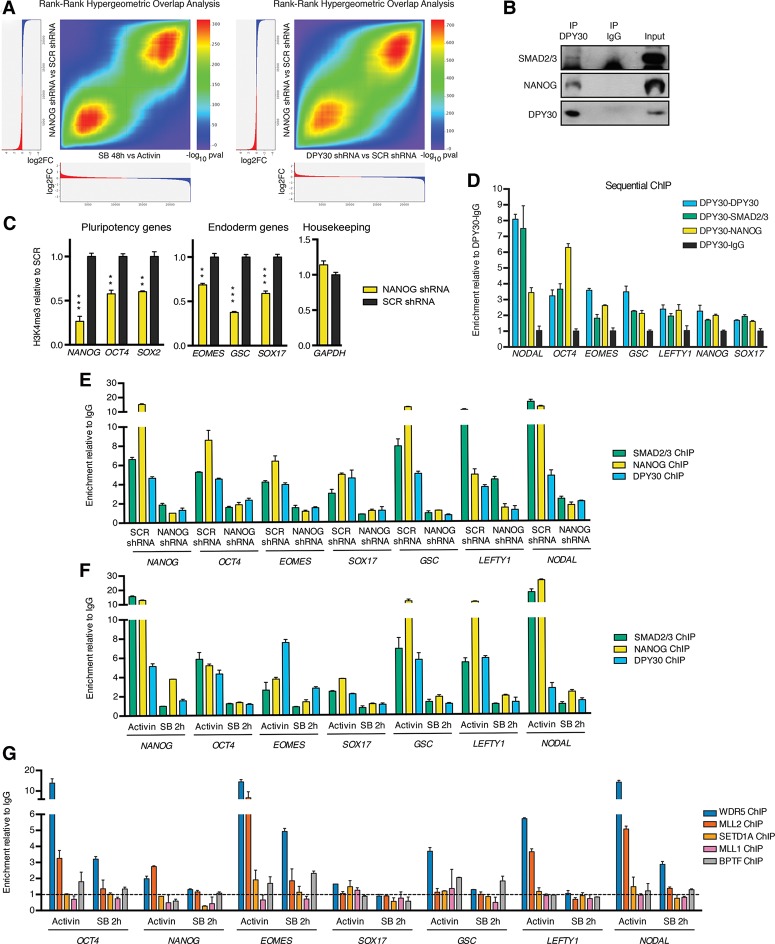
SMAD2/3 and NANOG recruit DPY30 onto their genomic targets. (A) RRHO analysis for genes ranked by their differential expression after NANOG knockdown (KD), DPY30 knockdown, or inhibition of Activin/Nodal for 48 h with SB. (B) Western blots of DPY30 or control (IgG) immunoprecipitations (IP) from nuclear extracts of hESCs. Input is 5% of the material used for immunoprecipitation. (C) ChIP-qPCR for H3K4me3 in NANOG knockdown or control hESCs. For each gene, significant differences versus SCR as calculated by t-test are reported. (D) Sequential ChIP-qPCR for DPY30 followed by SMAD2/3, NANOG, or control (IgG) ChIP. (E) ChIP-qPCR for the indicated proteins in NANOG knockdown or control hESCs. (F,G) ChIP-qPCR for the indicated proteins in hESCs before and after inhibition of Activin/Nodal with SB for 2 h. ChIP-qPCR results in D–G are representative of three independent experiments, and the location of primers used is shown in Supplemental Figure S5G.